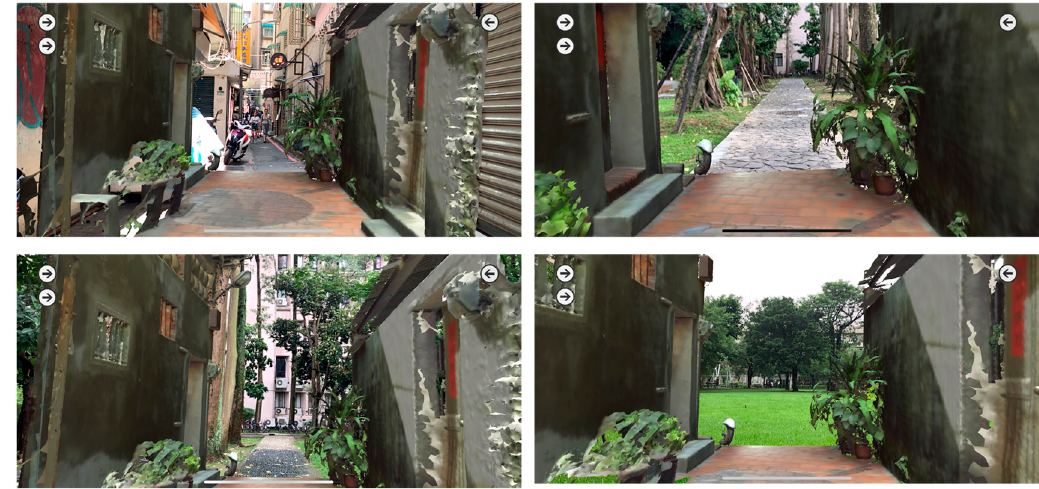
Figure 14. The combination of the real environment and 3D models.